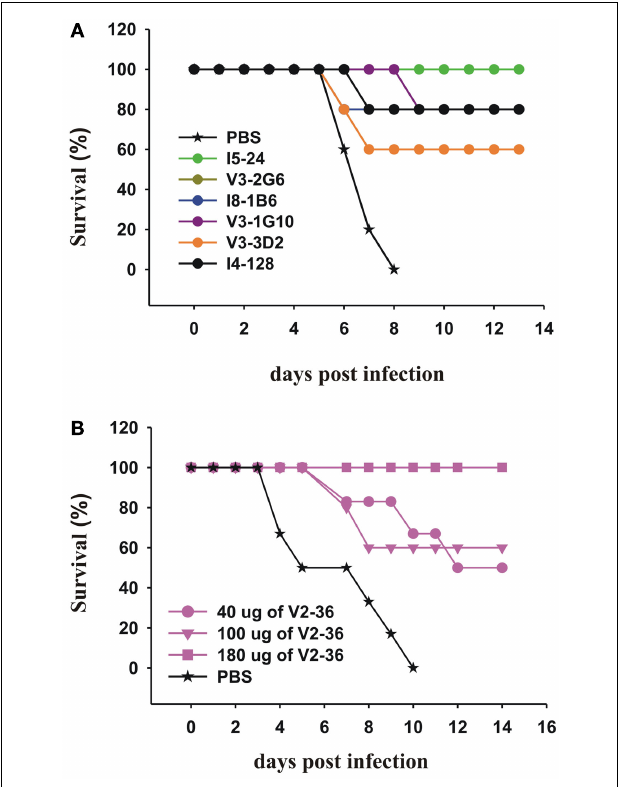
FIGURE 5 |Therapeutic effects of mAbs on lethal infections with a human isolate of pdmH1N1. (A,B) Groups of 5 CD-1 mice were infected intranasally with 2 × 10 5 PFU of A/Halifax/210/2009 (pdmH1N1).Twenty-four hours post-infection, the mice were treated IP with (A) 300 μ g of the indicated anti-HA stem mAbs (the survival curves forV3-2G6 and I8-1B6 are superimposed and mainly superimposed with the curve of I4-128) or (B) with the indicated doses of the anti-HA head mAb,V2-36.